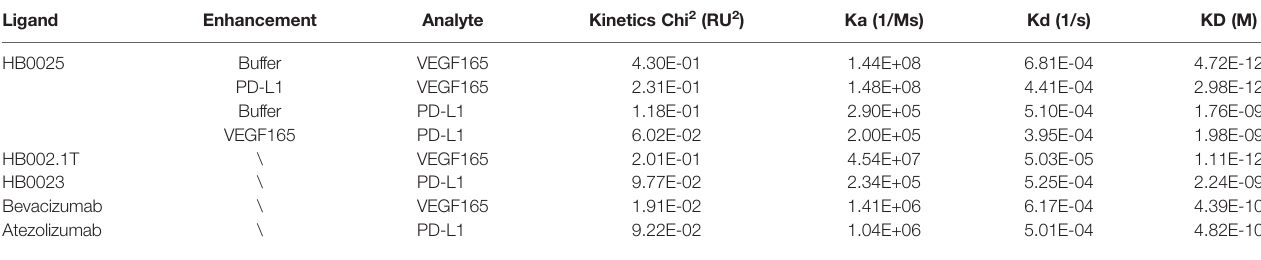
TABLE 3 | Kinetic results of samples binding to PD-L1 and VEGF with a 1:1 binding model.